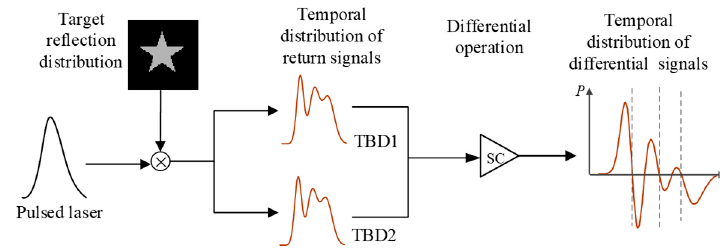
Figure 4. Step I: Depth information of targets is extracted based on finite difference.